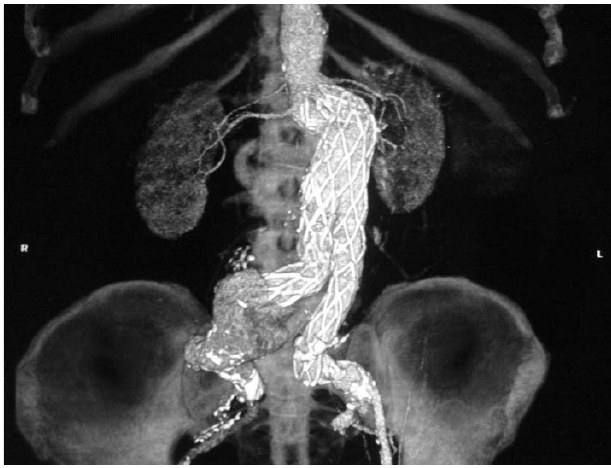
Fig. 1 - Computed tomography of the patient number 18, showing dilatation of the artery with right iliac with type IB endoleak after treatment with bifurcated stent-graft with a bell-bottom extension.